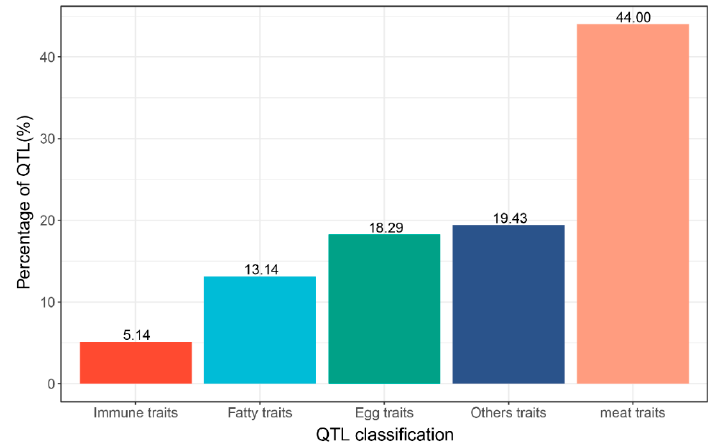
Figure 6. Statistics of QTL classification.